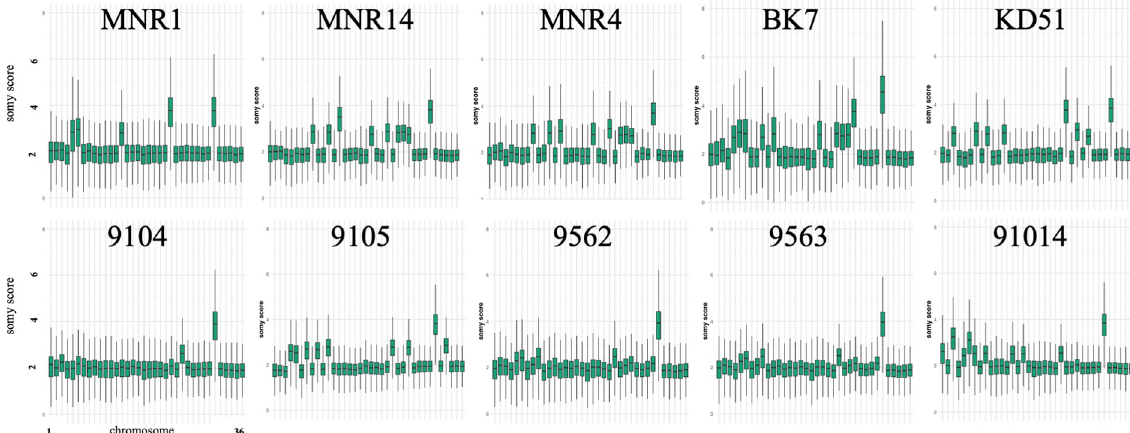
Fig 4. Chromosome copy number variations in sequenced strains of L . turanica